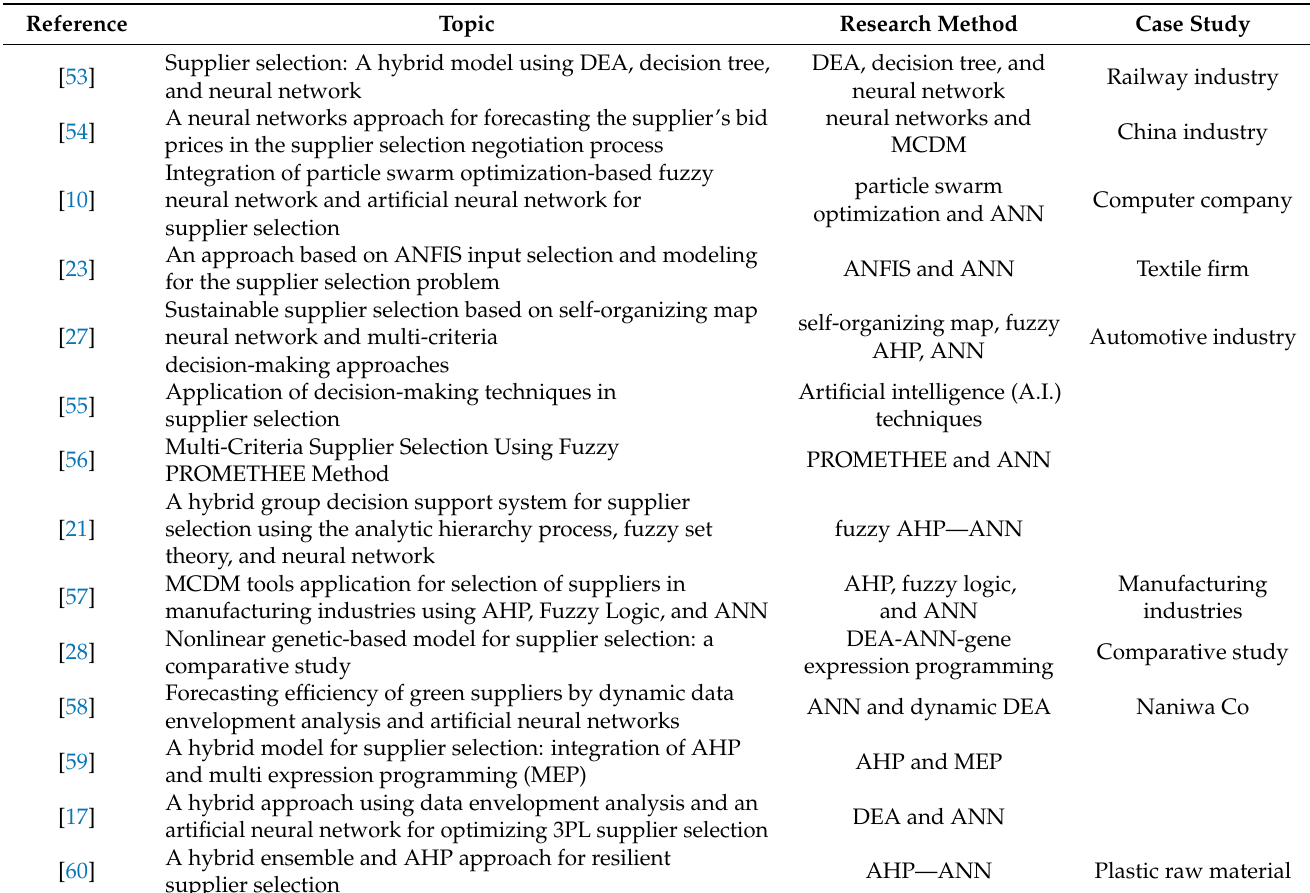
Table 2. Literature review for supplier selection based on neural networks.